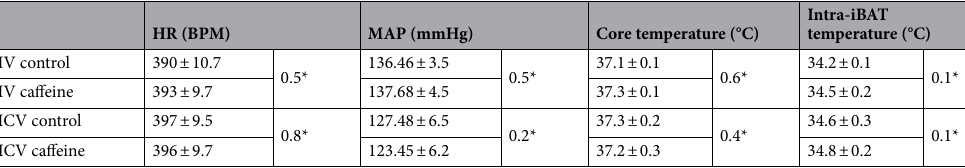
Table 1. Average baseline physiological measures prior to drug administration: statistical testing indicates no difference in base line conditions prior to interventions. *Indicates p-value calculated using an unpaired t-Test, Welch’s correction, n = 8 per